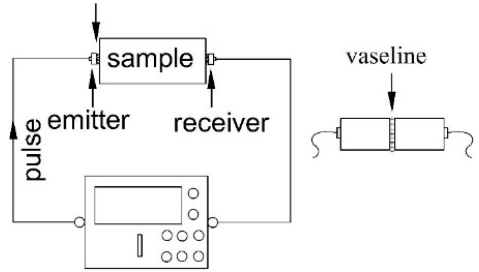
Figure 3. Acoustic wave testing of specimens.